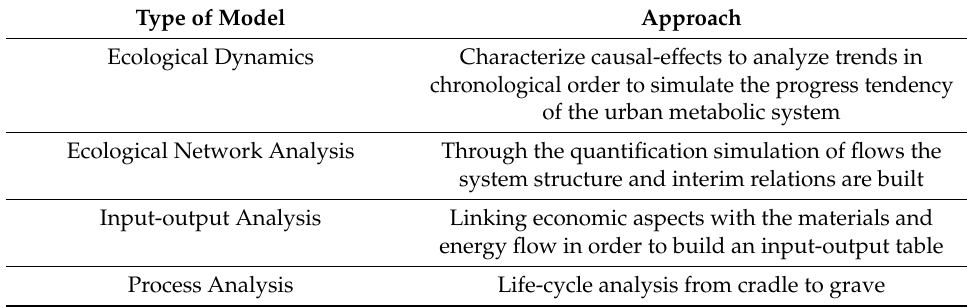
Table 1. Description of the main urban metabolism simulation methods (Zhang, 2013) [15]. Type of Model Approach Ecological Dynamics Characterize causal-e ff ects to analyze trends in chronological order to simulate the progress tendency of the urban metabolic system Ecological Network Analysis Through the quantification simulation of flows the system structure and interim relations are built Input-output Analysis Linking economic aspects with the materials and energy flow in order to build an input-output table Process Analysis Life-cycle analysis from cradle to